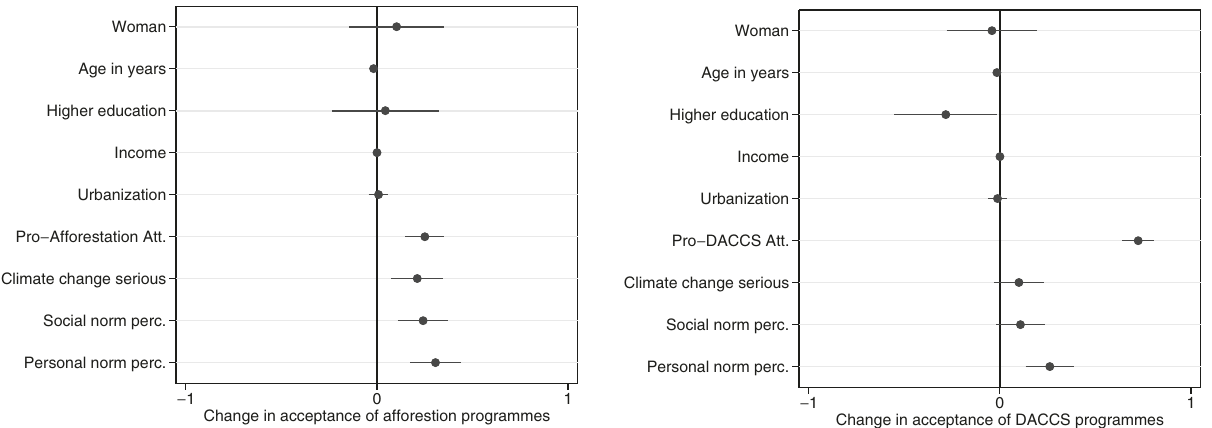
Fig. 6 Effects of respondents ’ individual characteristics and attitudes on the acceptability of CDR methods. Presented on the y -axis are effects (dots and 95% CIs) of respondent characteristics (gender, age, education, income, level of urbanisation of place of residence, attitude toward afforestation/DACCS, climate change concern, social norm perception, and personal norm perception, compare Table 2) on changes in acceptability measured on a 11-point scale ( x -axis). Effects of vignette attributes ( y -axis) are not shown. The results are based on random effects models; n = 1466. Positive effects refer to an increase in support and negative effects to a decrease. The effects for the categorical variables (woman, higher education) are relative to the respective base category. For full regression tables see Table S3 in the suppl. material.